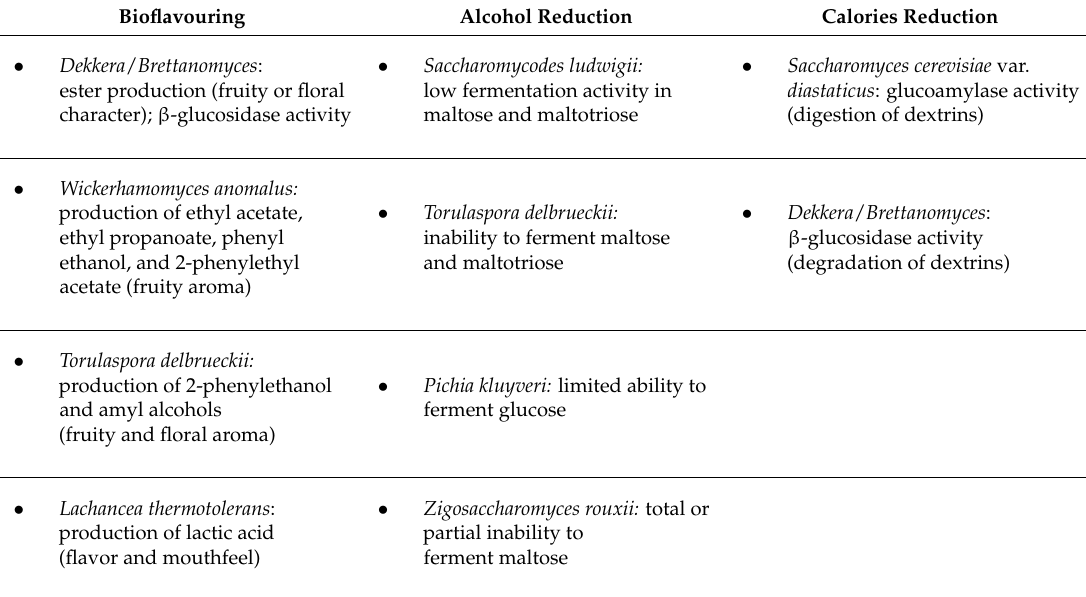
Table 1. Role of non-conventional yeasts for production of innovative